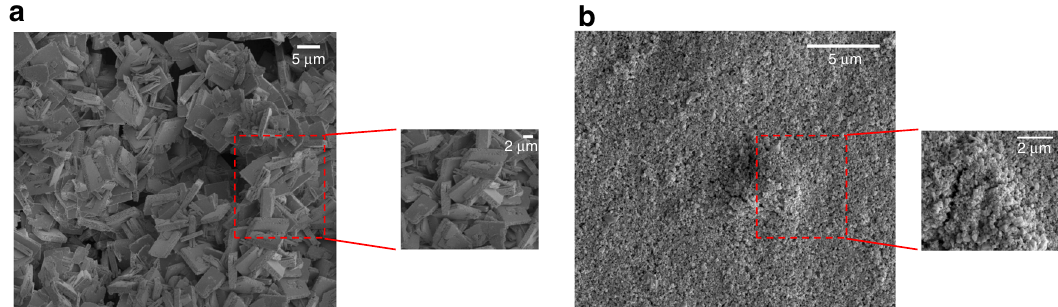
Fig. 5 Scanning electron microscopy of thin fi lms. SEM micrographs at a high and low magni fi cation of a KAUST-7 and b KAUST-8 thin fi lms coated on the gold electrode of